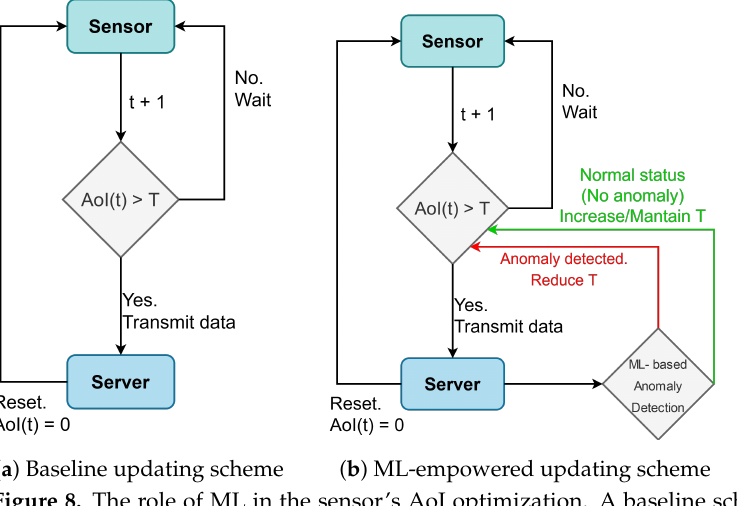
Figure 8. The role of ML in the sensor’s AoI optimization. A baseline scheme without ML ( a ) is compared with an ecosystem with ML in the loop ( b ), with a dynamic adjustment of the AoI policy (i.e., updating a threshold T